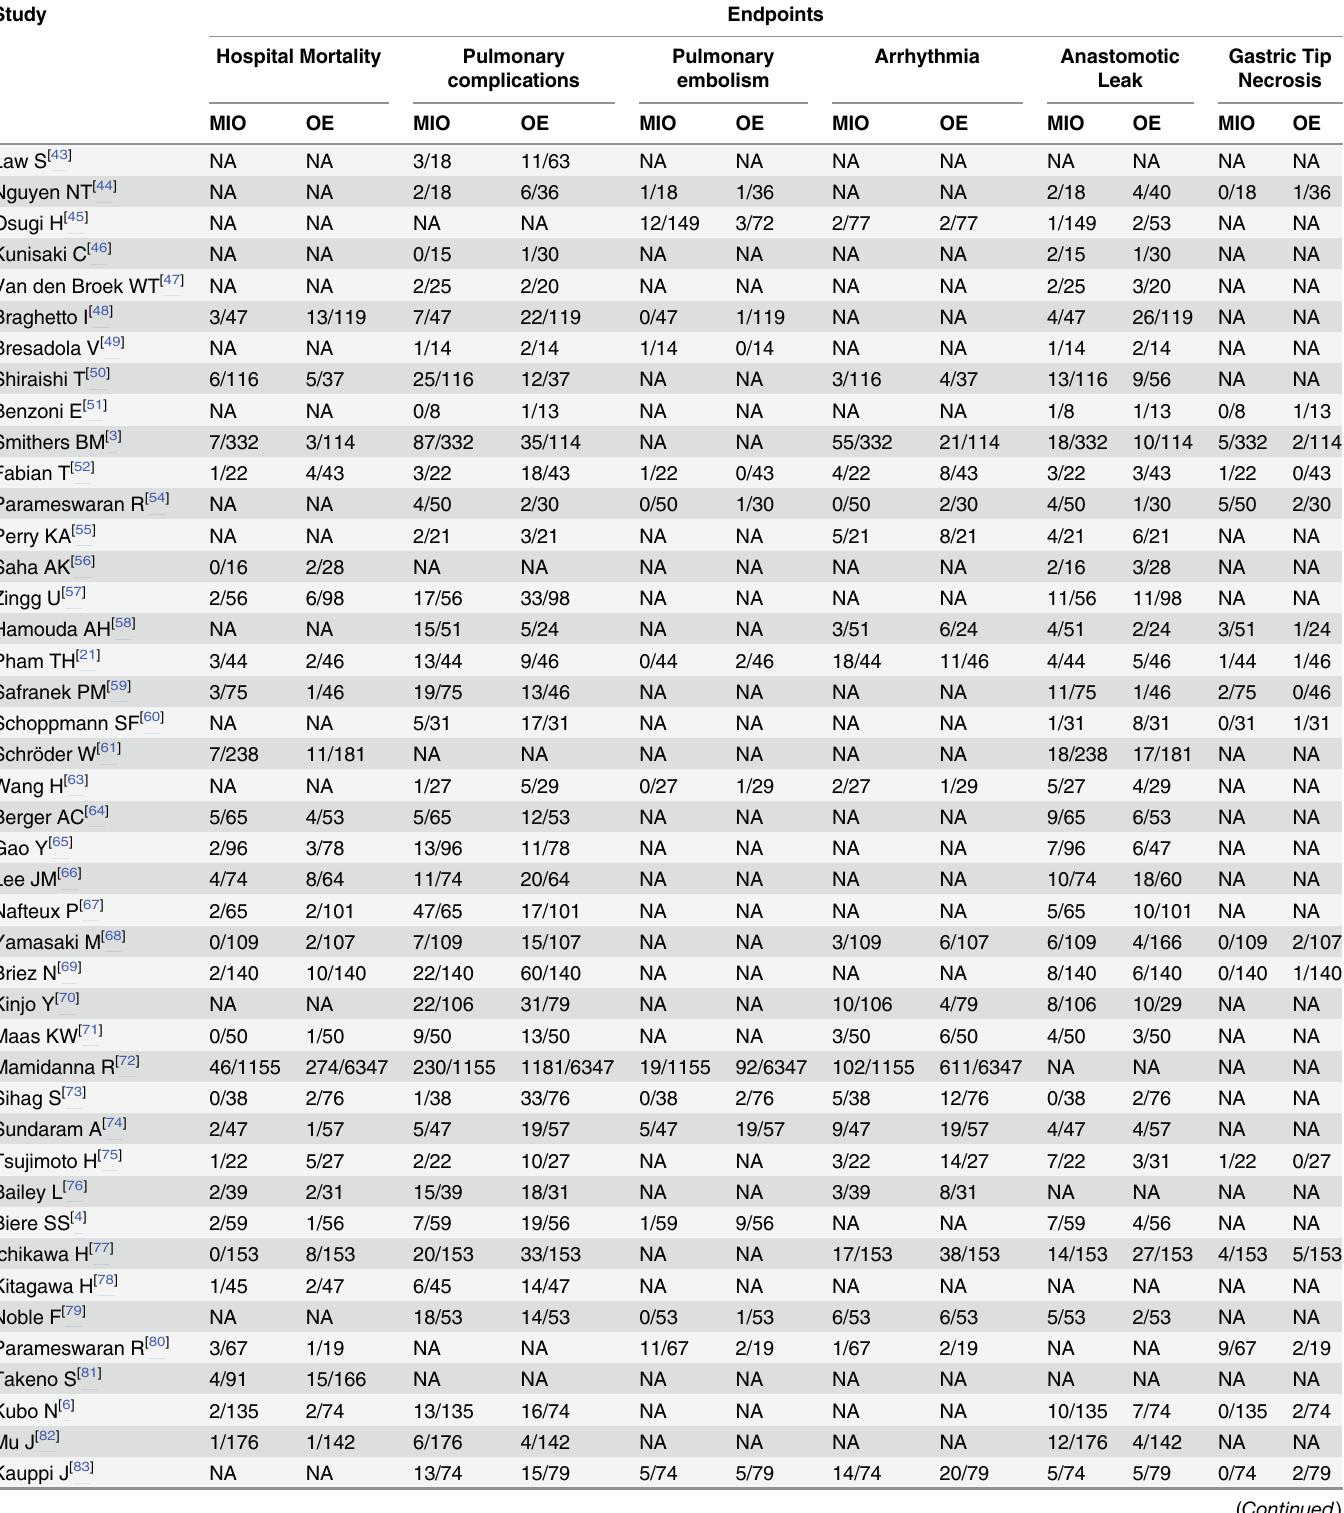
Table 2. Outcomes of interest in Included